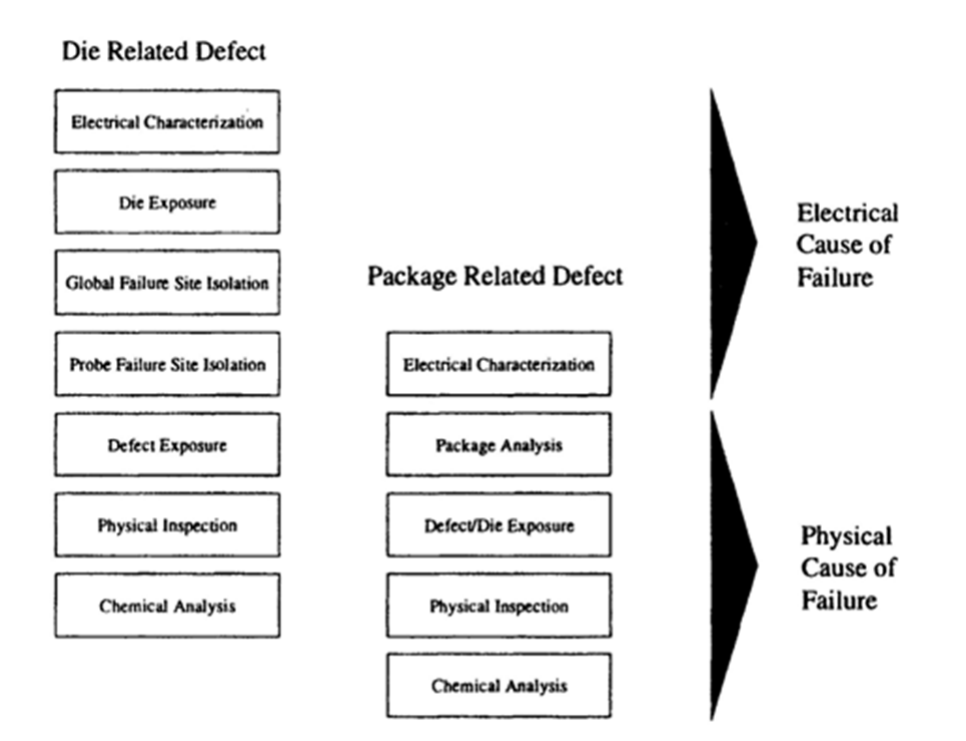
Figure 7 Typical failure analysis process flows for die related and package related defects are shown for comparison. Each flow can be broken down in to an electrical cause of failure determination and physical cause of failure